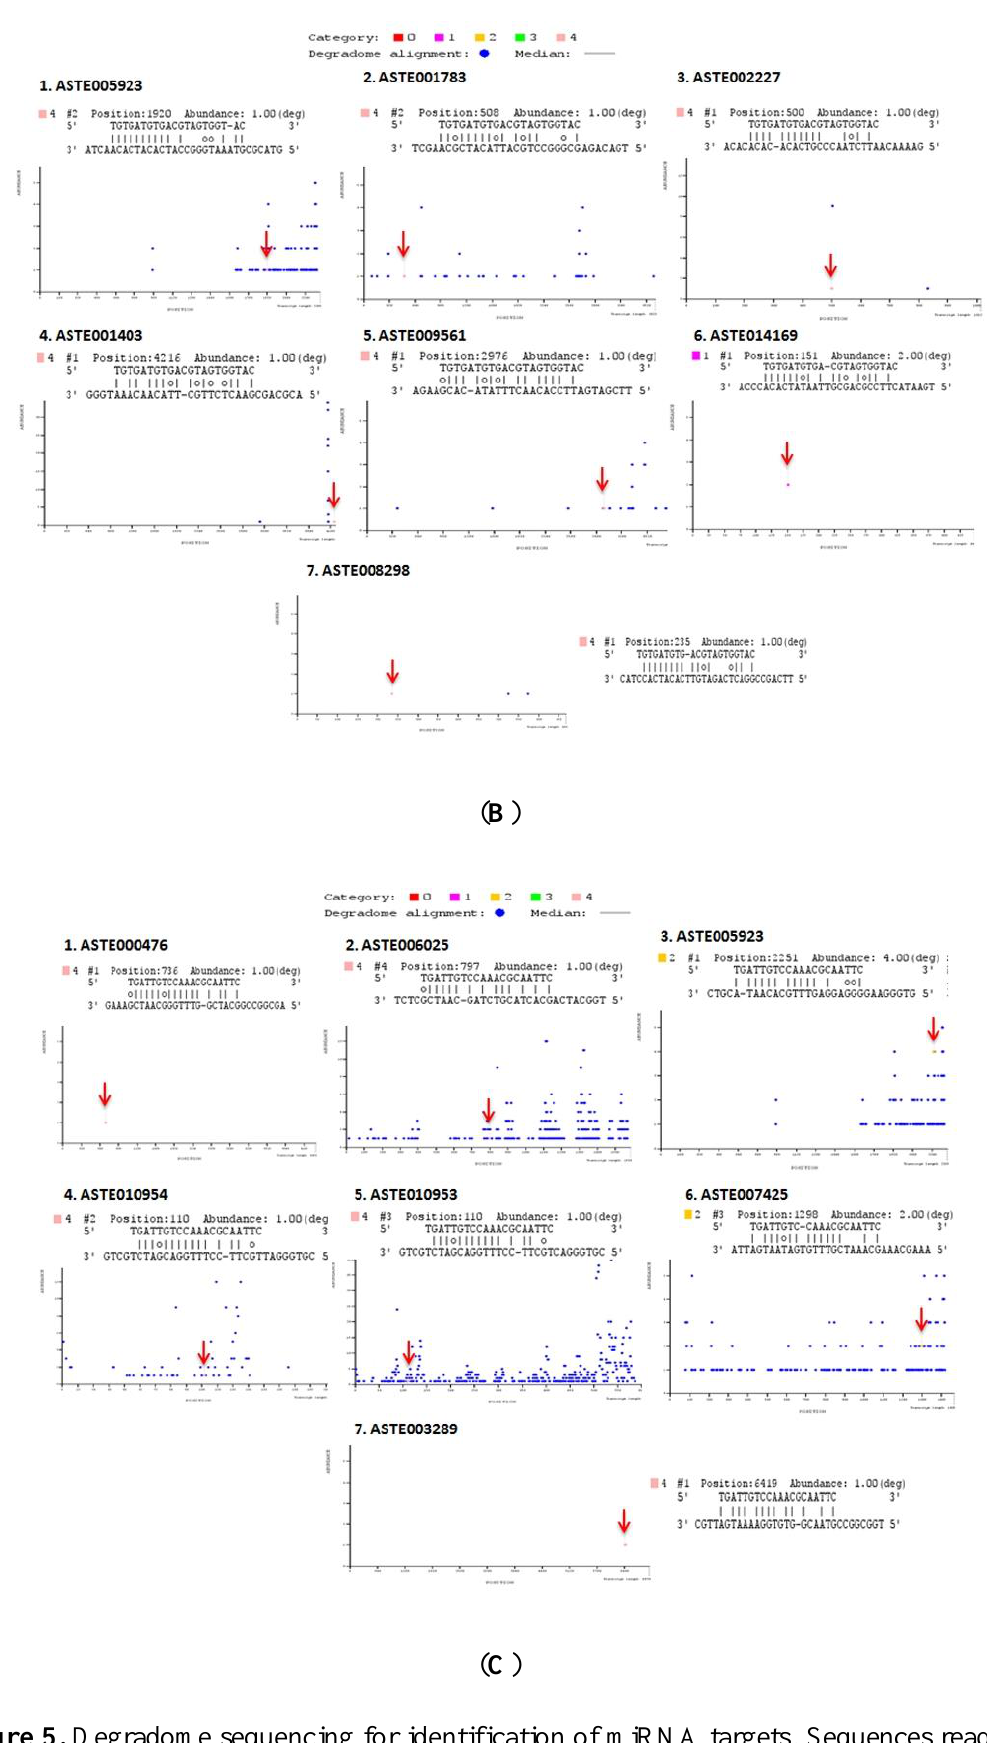
Figure 5. Degradome sequencing for identification of miRNA targets. Sequences reads are mapped on to the entire length of the transcript along with miRNA sequences